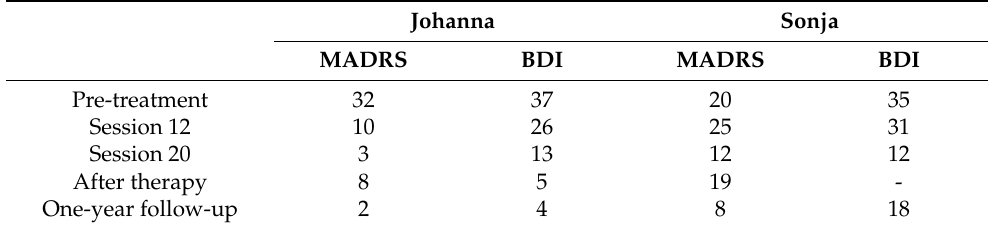
Table 1. MADRS and BDI scores for Johanna and Sonja.